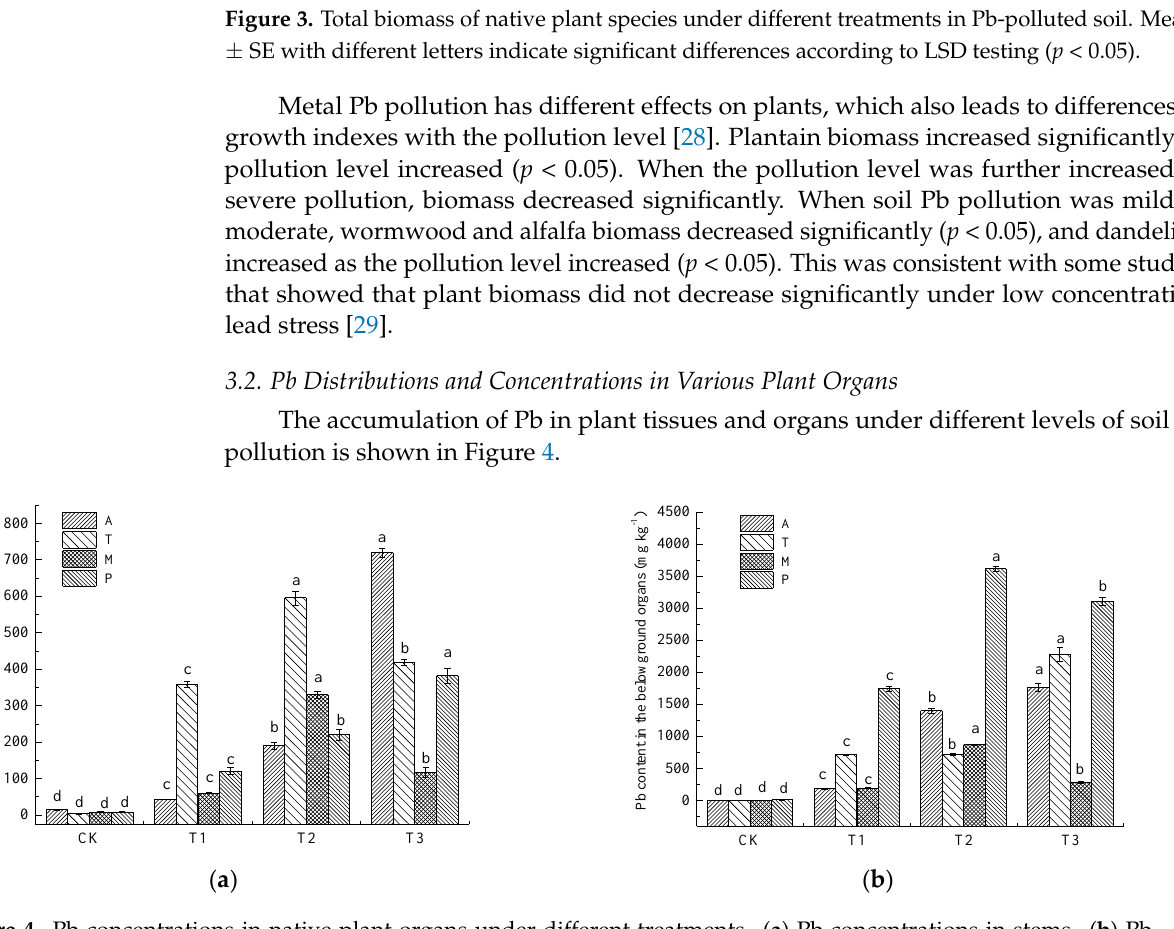
Figure 4. Pb concentrations in native plant organs under different treatments. ( a ) Pb concentrations in stems. ( b ) Pb concentrations in roots. Means ± SE with different letters indicate significant differences according to LSD testing ( p < 0.05). Under different treatment conditions, Pb contents in plant tissues and organs reached significant levels compared with the control treatment ( p < 0.05). This showed that soil Pb pollution had different effects on the Pb content of four native plants in the northwest mining area. Different plants had different absorption and accumulation characteristics of Pb in polluted soil and increases of Pb content across plant tissues and organs were sig- nificantly different as soil Pb content increased. When the target Pb content of polluted soil was less than 5 ‰ , the Pb content of wormwood increased as the soil Pb content in- creased ( p < 0.05). The Pb contents in stems and roots were the highest in T3 (up to